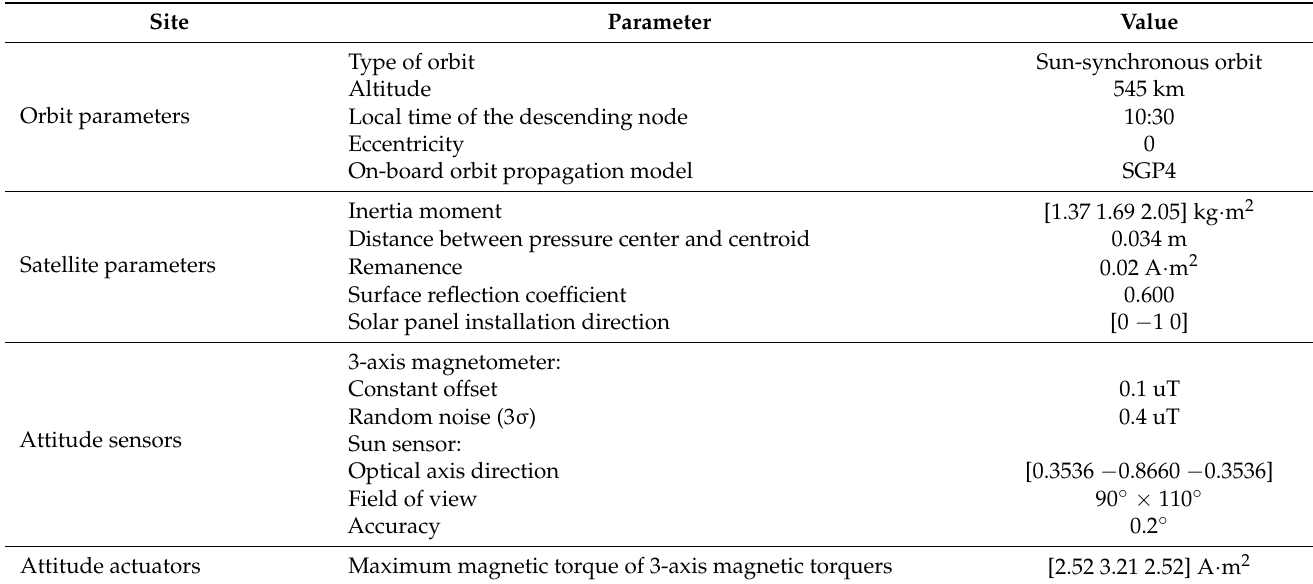
Table 1. Numerical simulation